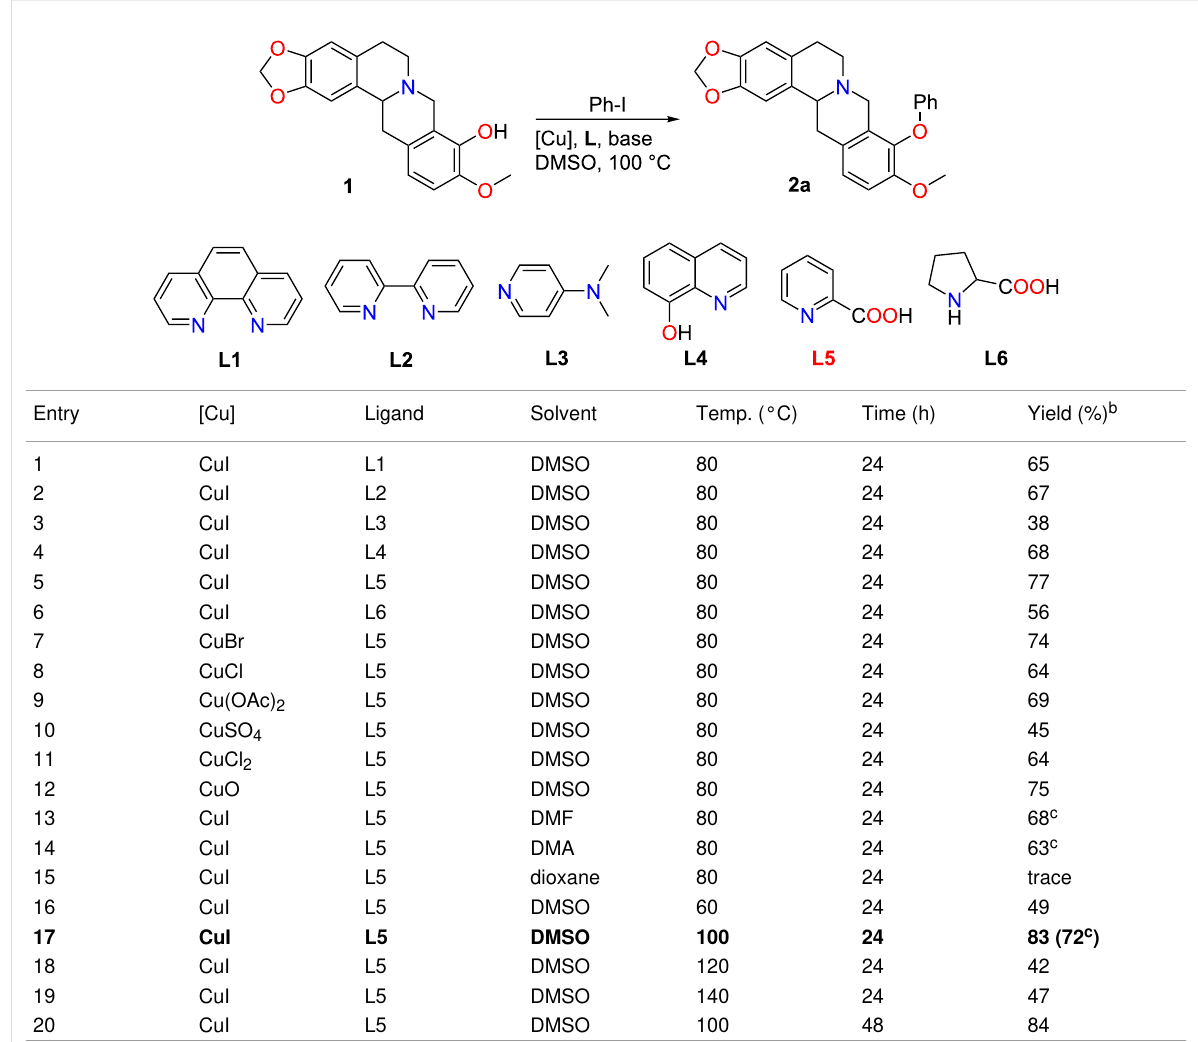
Table 1: Optimization of the reaction conditions.